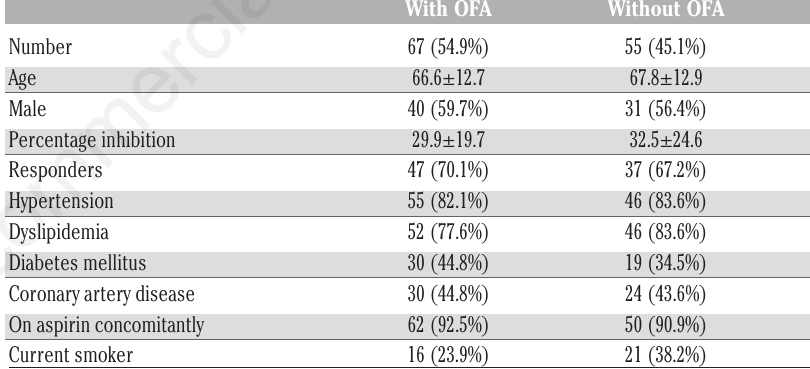
Table 1. The characteristics of subjects who received clopidogrel loads.